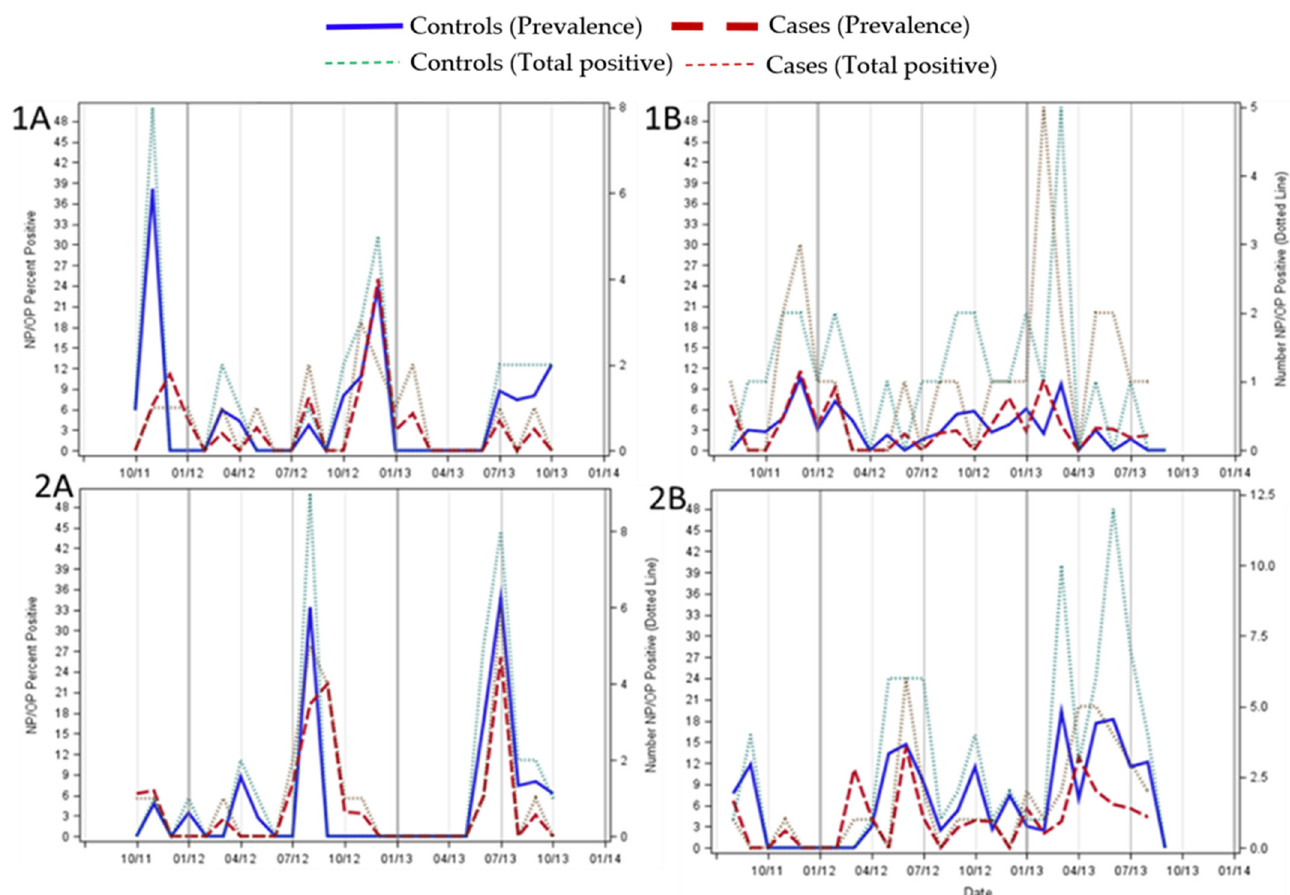
Figure 2. The seasonal distribution of Alphacoronavirus endemic species (Panel ( 1A ) and ( 1B )) and Betacoronavirus endemic species (Panel ( 2A ) and ( 2B )) over a period of two years in children hospitalized with pneumonia and asymptomatic controls in Zambia (Panel ( 1A ) and ( 2A )) and South Africa (Panel ( 1B ) and ( 2B )). Prevalence is the % of samples that tested positive for HCoV for each month for cases (dashed red line) and controls (solid blue line), with the actual number of HCoV positives for each month on the z axis for cases (dotted green line) and controls (dotted red line).